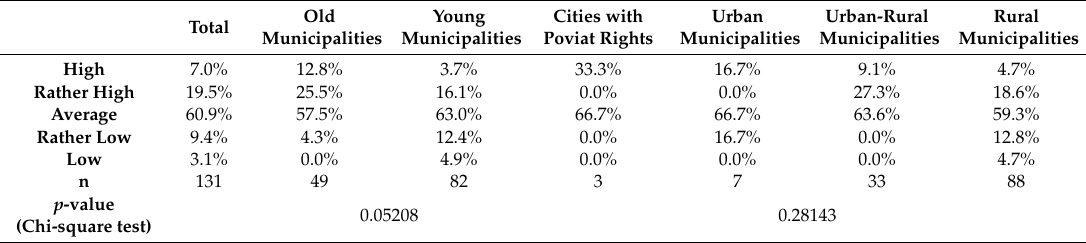
Table 3. Assessment of the degree of intensity of the aging process in the analysed municipalities. Old Total